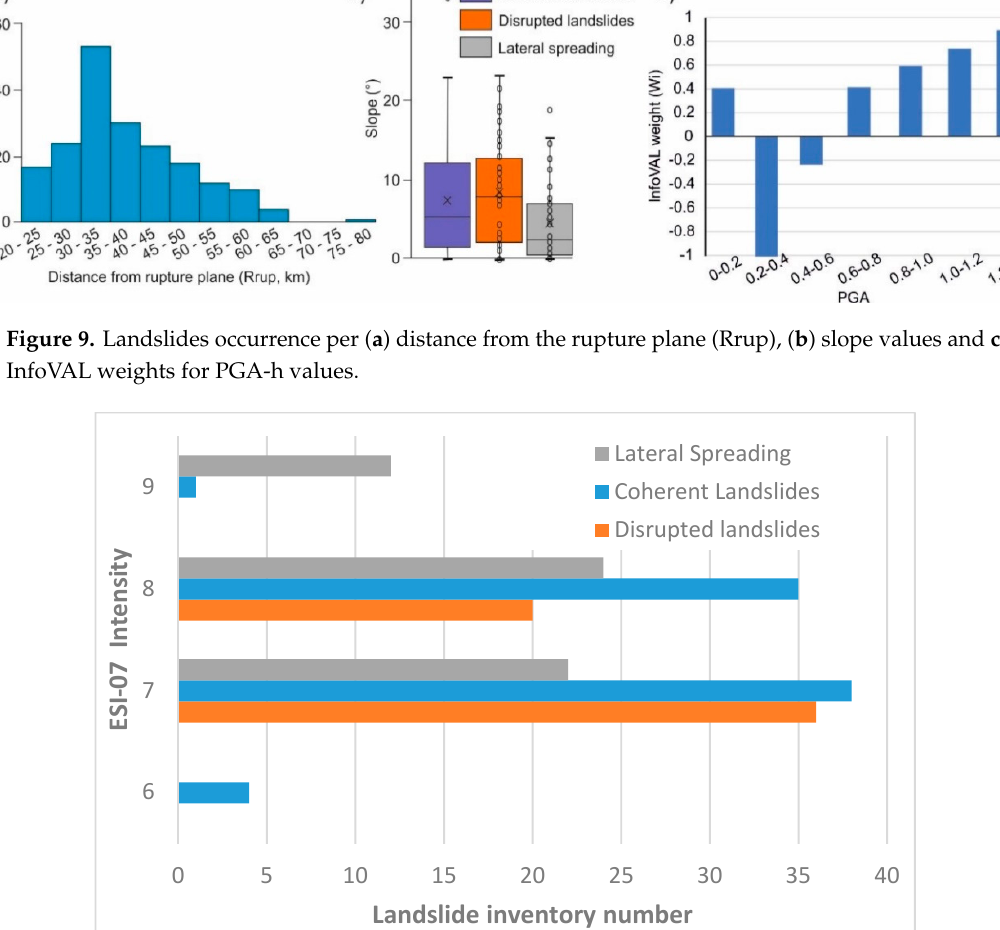
Figure 10. Distribution of coseismic landslides types as a function of assessed ESI-07 macroseismic intensity.